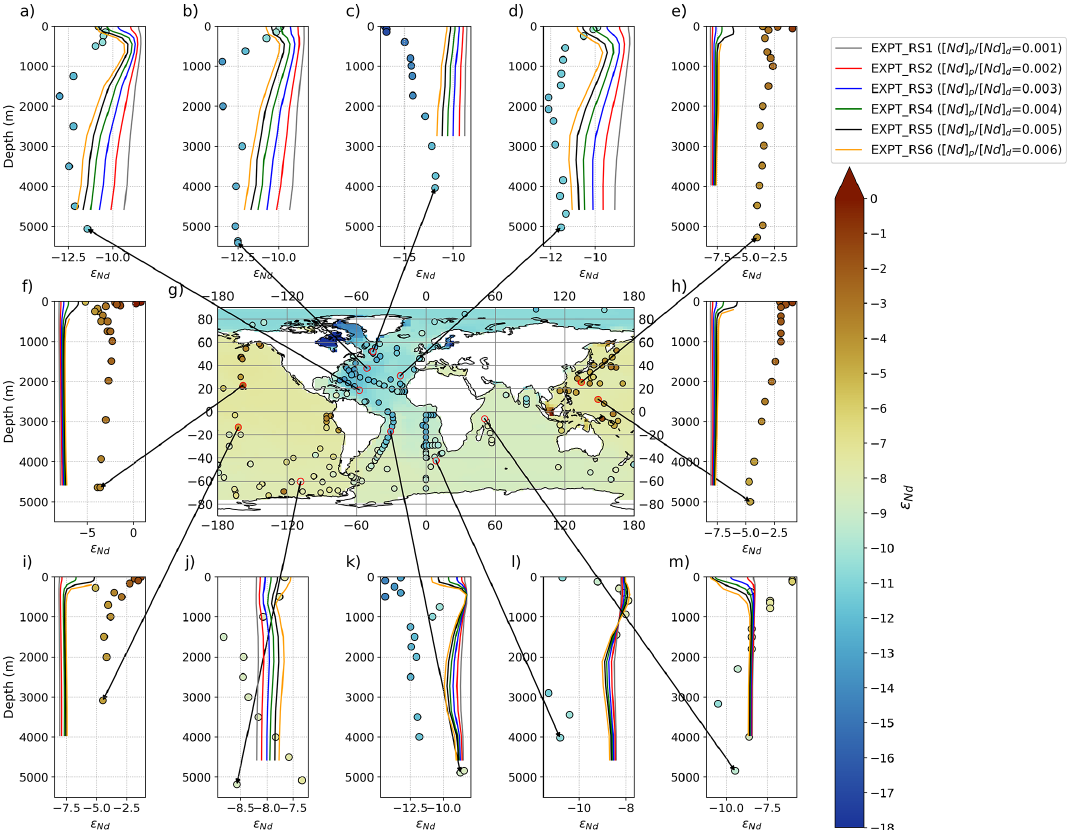
Figure 12. The central panel (g) displays ε Nd at the seafloor (i.e. lowermost box of the ocean model) in simulation EXPT_RS4 (100-year mean from the end of the run), with superimposed water column measurements (Osborne et al., 2017, 2015; GEOTRACES Intermediate Data Product Group, 2021) from ≥ 3000m shown by filled coloured circles on the same colour scale. The surrounding panels (a) – (f) and (h) – (m) display depth profiles of simulated (coloured lines, one per sensitivity simulation with varied [ Nd ] p / [ Nd ] d ) and measured (filled circles) ε Nd , respectively. Larger shifts in the ε Nd between simulations highlight the regions most sensitive to the efficiency of reversible